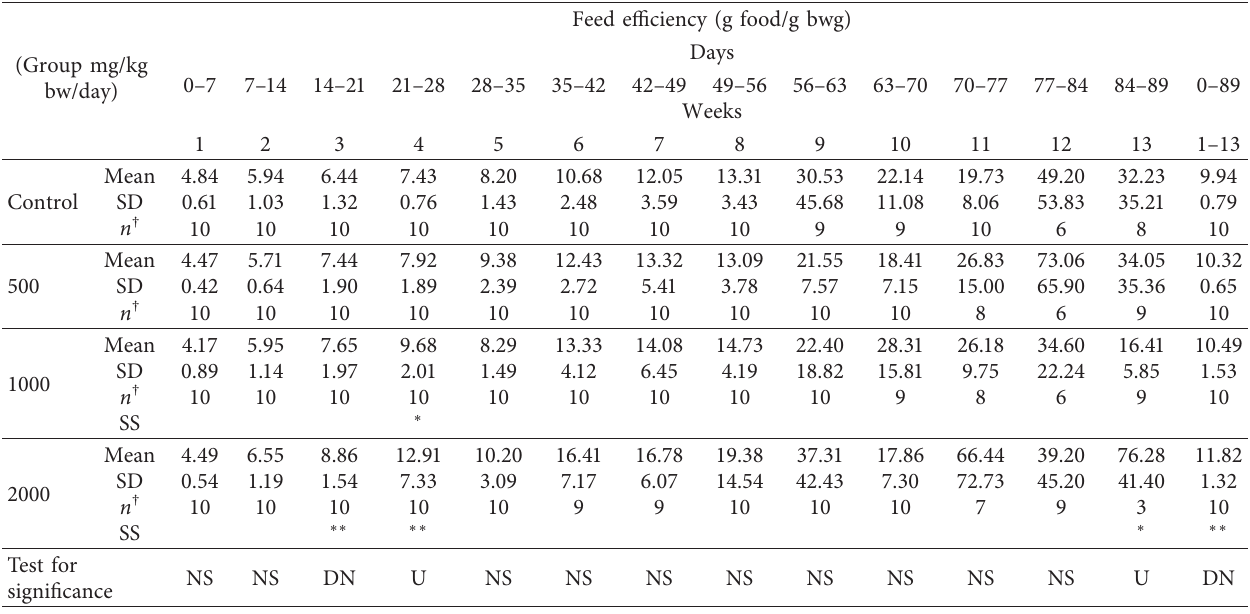
Table 7: Summary of feed efficiency (males), 90-day study.